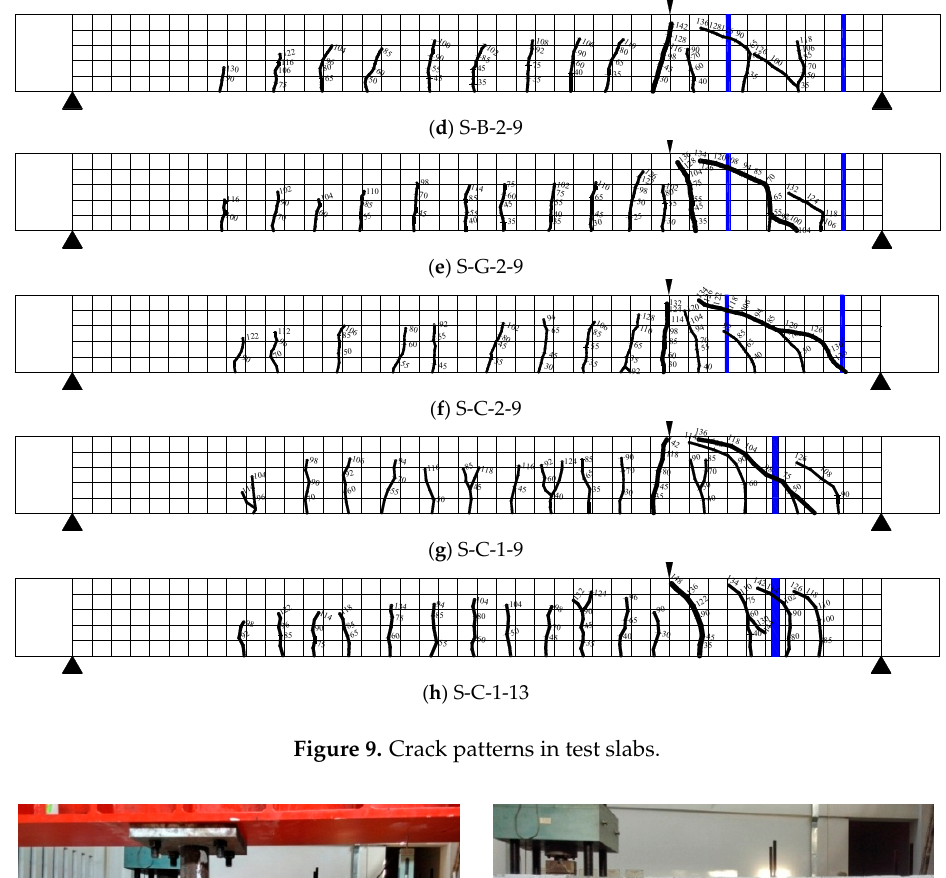
Figure 9. Crack patterns in test slabs.